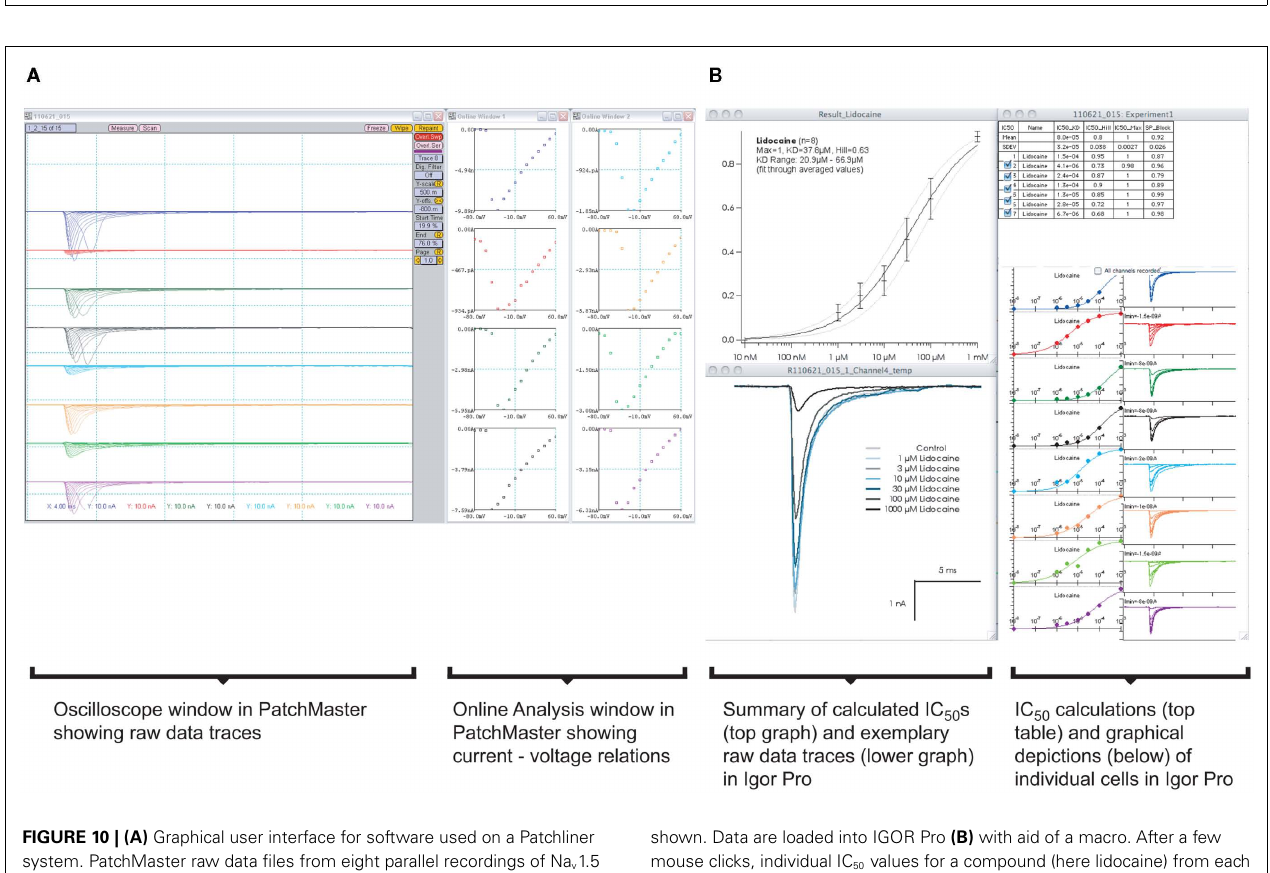
FIGURE 9 | Multiple compound additions can be performed, allowing the generation of full concentration response curves on individual cells. (A) P2X 2/3 receptors expressed in a 1321N1 cell were repeatedly activated by 10 μ M ATP (three times activation with